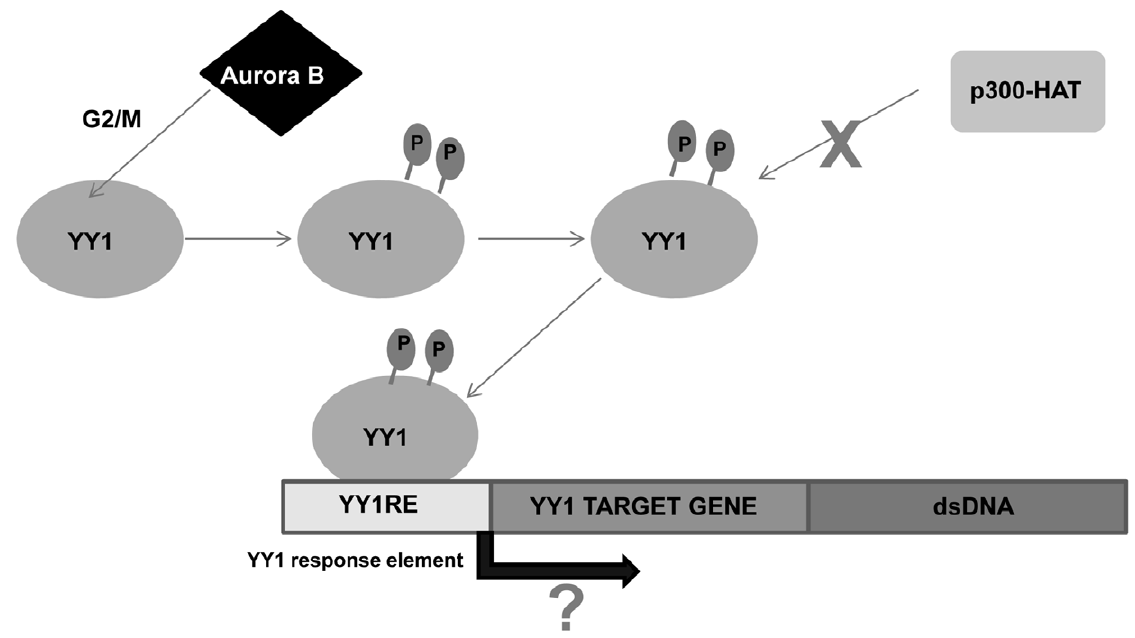
Figure 7. Schematic model of the regulation of YY1 by Aurora B at G2/M. YY1 is an Aurora B substrate at G2/M. Phosphorylation of YY1 in the regulatory domain prevents its association and acetylation by the histone acetyltransferase p300 and regulates YY1 DNA binding